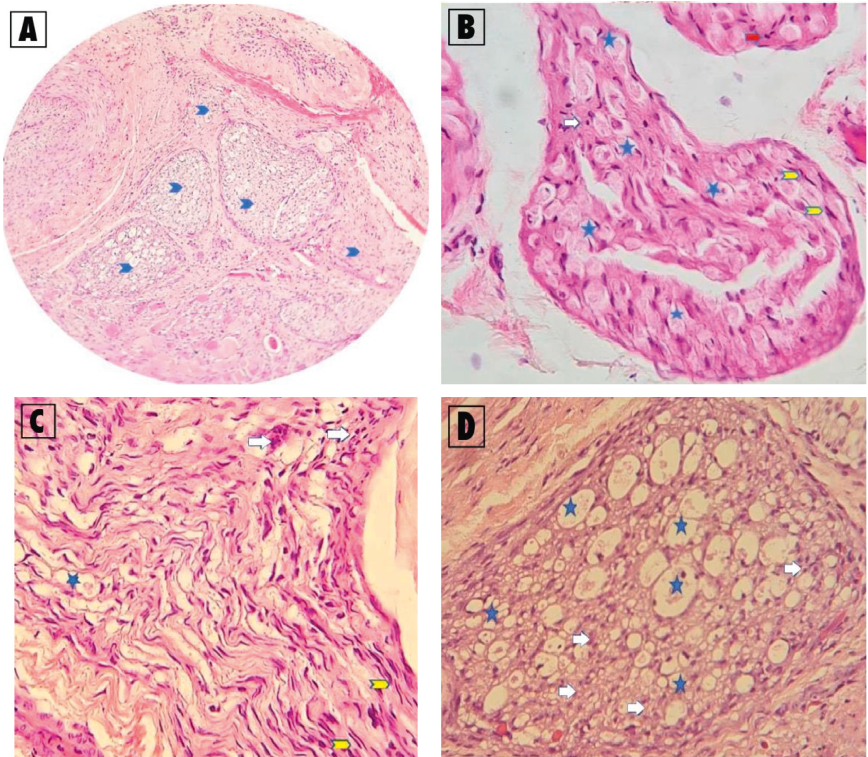
Figure 2: Histopathological evaluation using Hematoxylin Eosin (HE) stain. (A) Five fragments of nerve bundle from 1 sample specimen (100x) from which each bundle would be counted for inflammatory cells and endoneurium vacuole as cell percentage areas (200x). (B) Slides from group 1 with dominant vacuole > 30% but less dominant inflammatory cells in 200x magnification. (C) Slides from group 4 with minimum inflammation cells and vacuoles ( < 5%) in 200x magnification. (D) Slides form group 2 with vacuoles covering almost all of the nerve ( > 50%) and dominant inflammatory cells ( > 20%) in 200x magnification. Blue arrow means nerve bundles; blue stars mean vacuoles; yellow arrows mean Schwann cells; and white arrow means inflammatory cells.